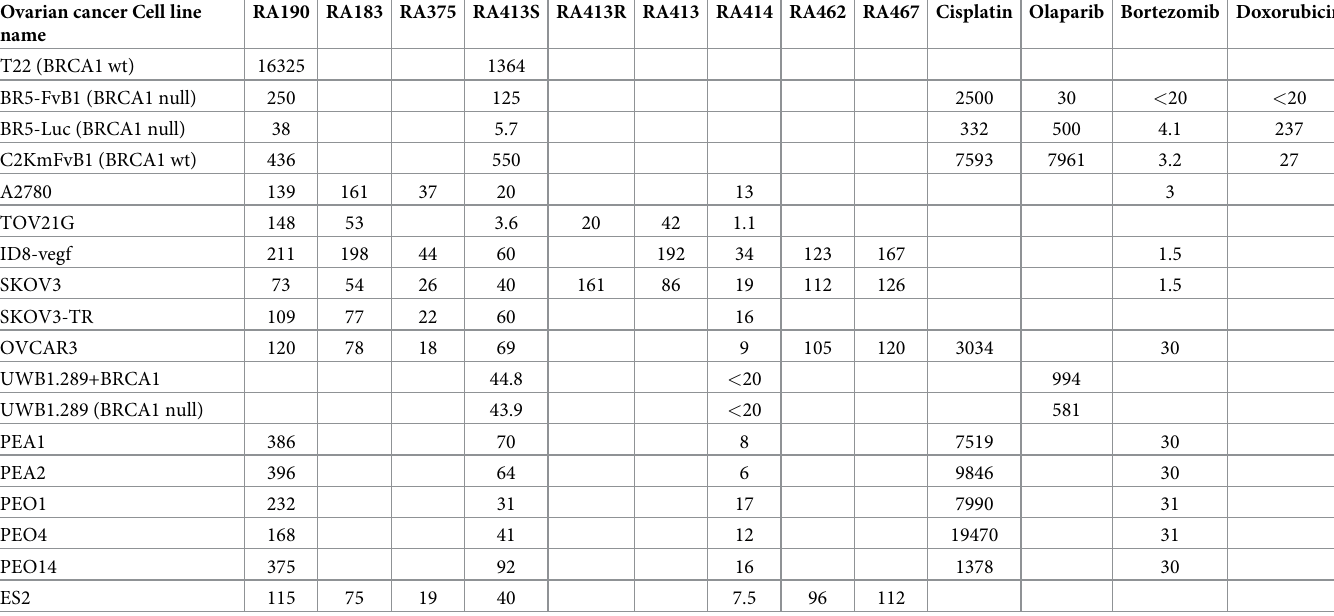
Table 1. IC50 measurements for candidate iRPN13s in ovarian cancer cell lines (nM). T22, BR5-FvB1, BR5-Luc, C2KmFvB1 and ID8-vegf are murine model lines, and the remainder are of human origin. Ovarian cancer Cell line